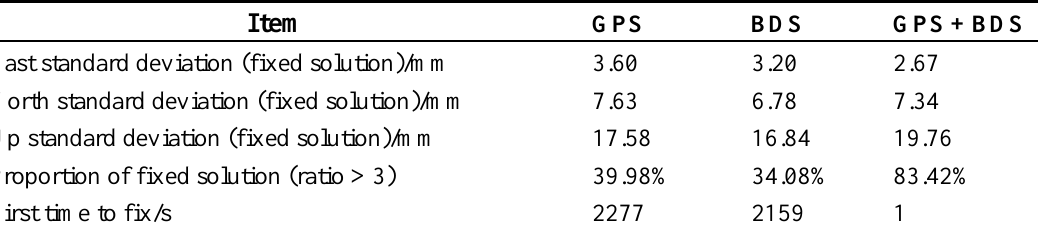
Table 3. Statistics of 5.9 km baseline